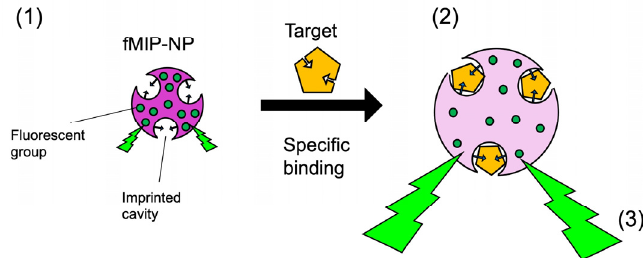
Figure 9. Possible principle of increased fluorescence intensity due to swelling of fMIP-NPs upon specific binding. (1) Fluorescent functional groups are densely packed in fMIP-NPs, and the fluorescence intensity is suppressed by self-quenching. (2) However, the distance between the fluorescent functional groups increases by swelling in conjunction with specific binding to the target substance used as a template. (3) Finally, self-quenching is suppressed, and fluorescence intensity increases.